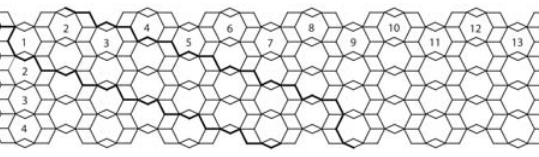
Figure 4: The shortest paths having maximal length in TiO